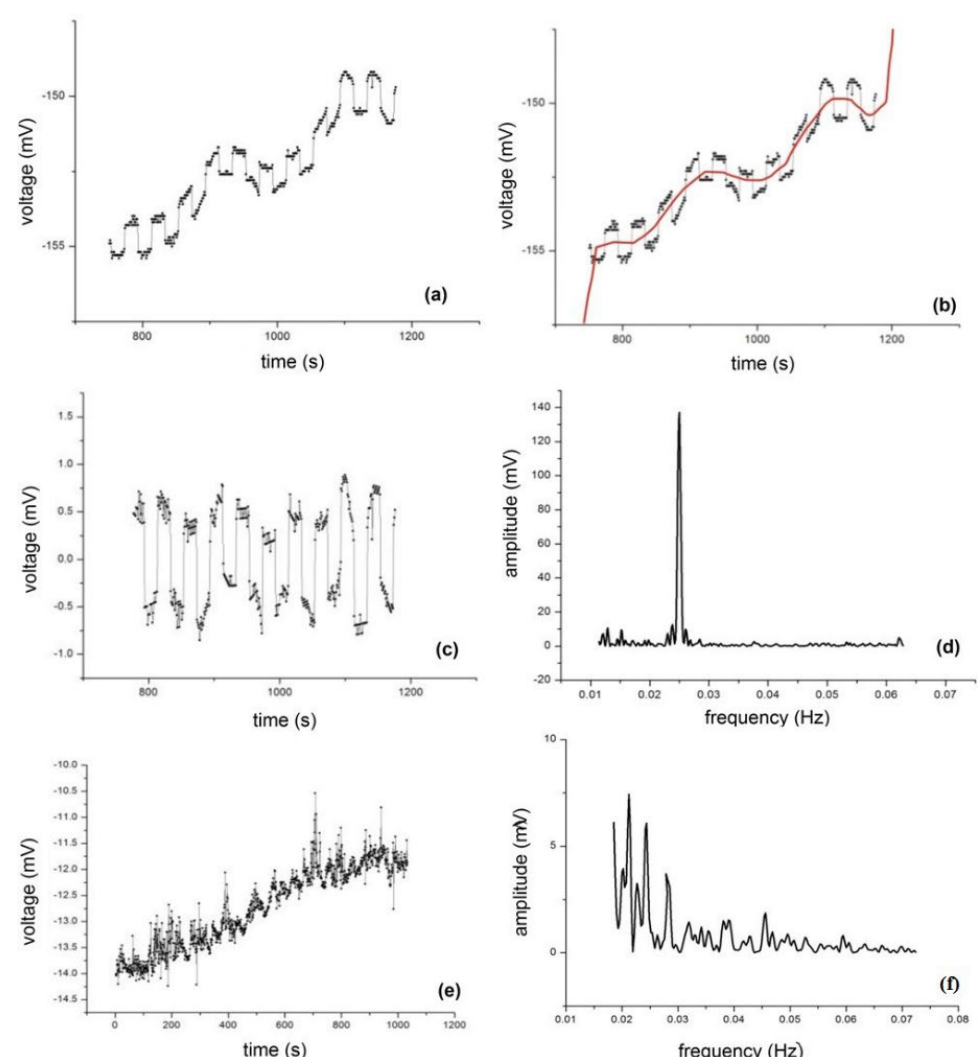
Figure 2. ( a ) Example of a voltage recording affected by trend. ( b ) The trend estimation (red line) by a polynomial fitting. ( c ) An example of a signal recording with a good signal-to-noise ratio. ( d ) Spectral amplitude of the Fourier Transform of the signal reported in ( c ), the peak at the energization frequency (0.025 Hz) representing the amplitude of the useful signal s ( t ). ( e ) An example of a signal recording with a very low signal-to noise ratio. ( f ) Fourier analysis of the signal reported in ( e ); the main peak is not at the energization frequency. (Reprinted with permission from [16], Copyright (2019), Taylor and Francis).